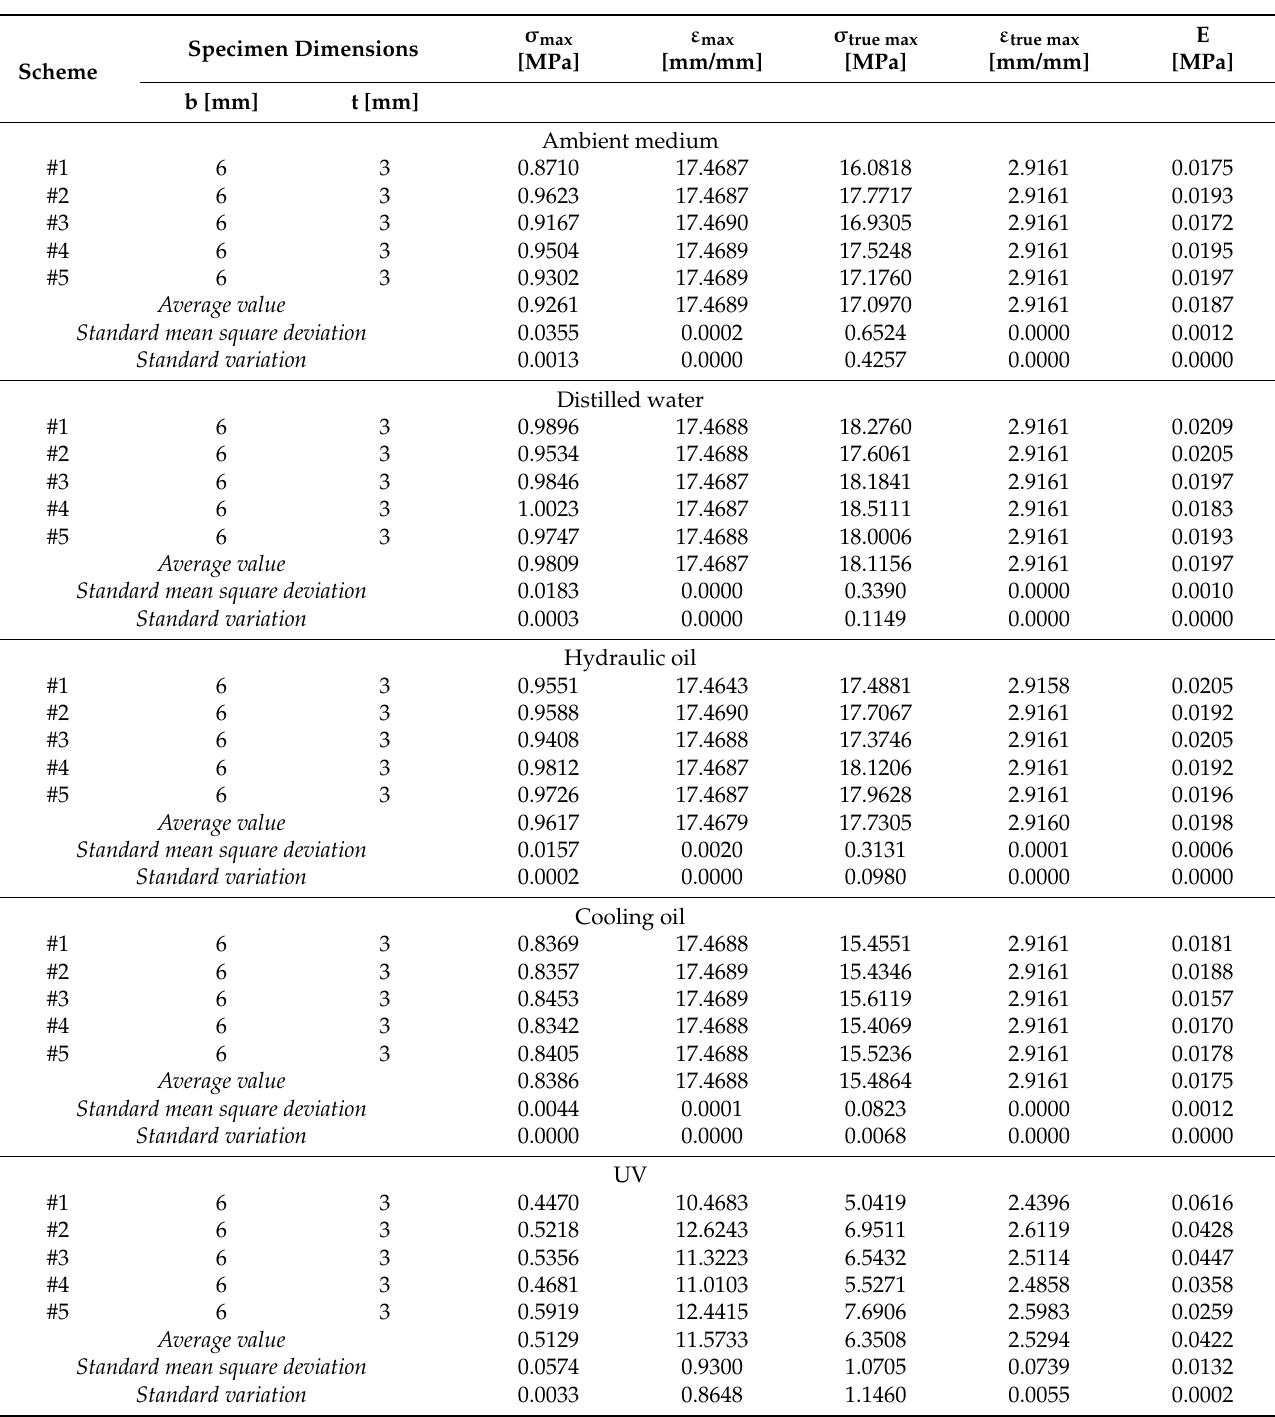
Table 5. Dimensions of 00-10 specimens, maximum tensile stress, maximum tensile strain, maximum true stress, maximum true strain, and maximum tensile